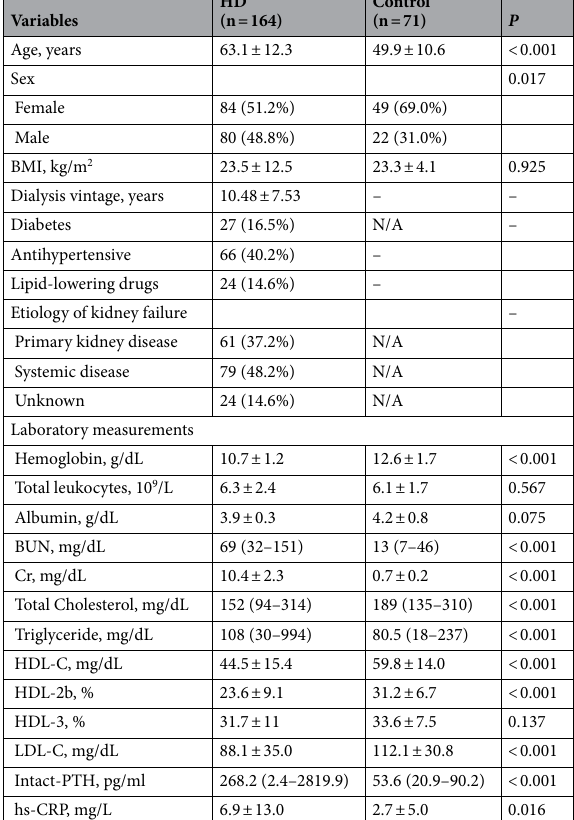
Table 1. Baseline characteristics in study cohort (N = 235). BMI body mass index, HDL high-density lipoprotein, LDL low-density lipoprotein, C cholesterol, T total, PTH parathyroid hormone, BUN blood urea nitrogen, Cr creatinine, hs-CRP high-sensitivity C-reactive